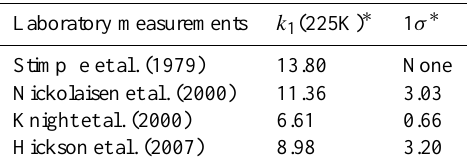
Table 1. k 1 and the error (1 σ ) calculated based on previous labora- tory studies at